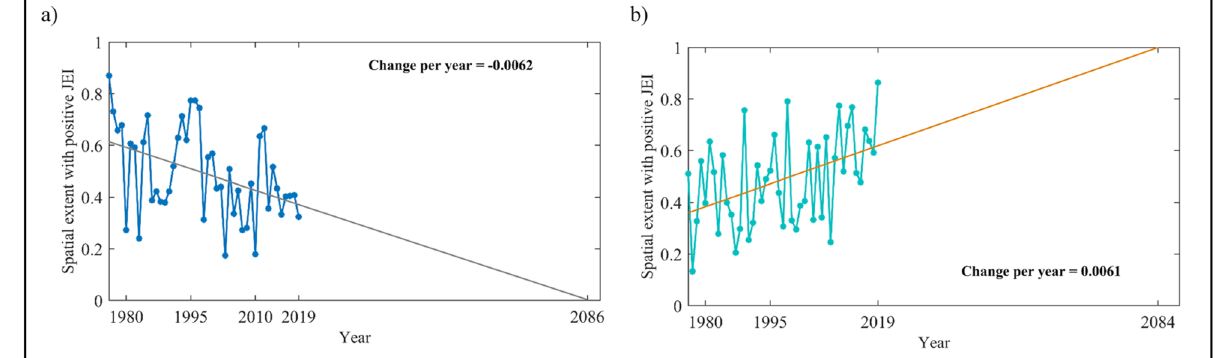
Figure 5. Future projection of observed significant change (during 1975–2019) in spatial extent (in proportion of entire Indian mainland) exhibiting positive Joint Extreme Indices (JEIs): ( a ) Cold and Wet Spell (CWS) and ( b ) Hot Nights and Wet Days